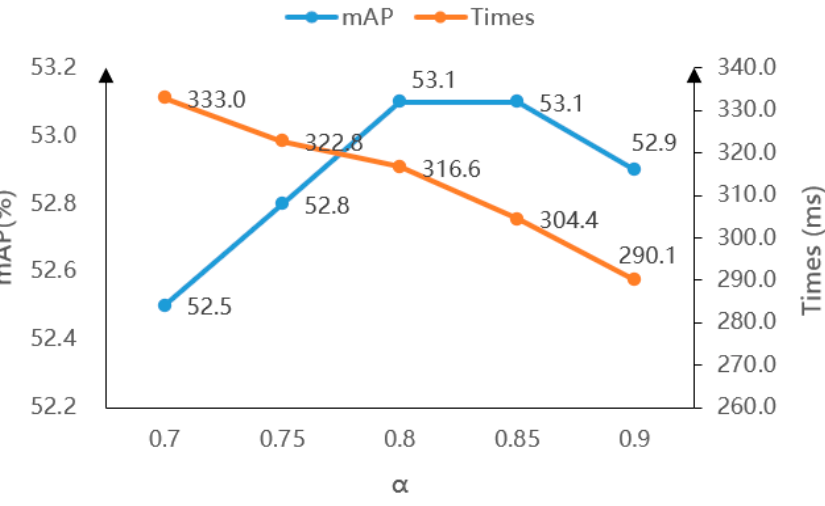
Figure 8. The influence of different α on model’s detection accuracy and time.